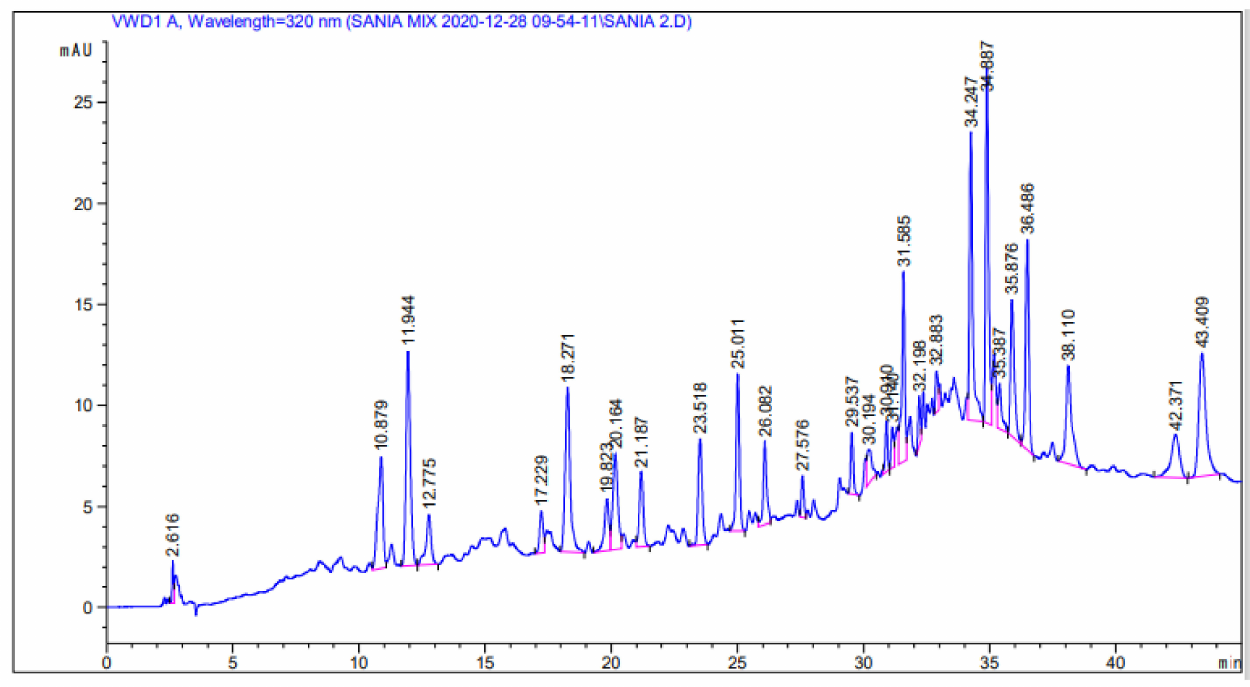
Figure 1. TPC and TFC of Met-Ext and purified fractions of Cydonia oblonga .